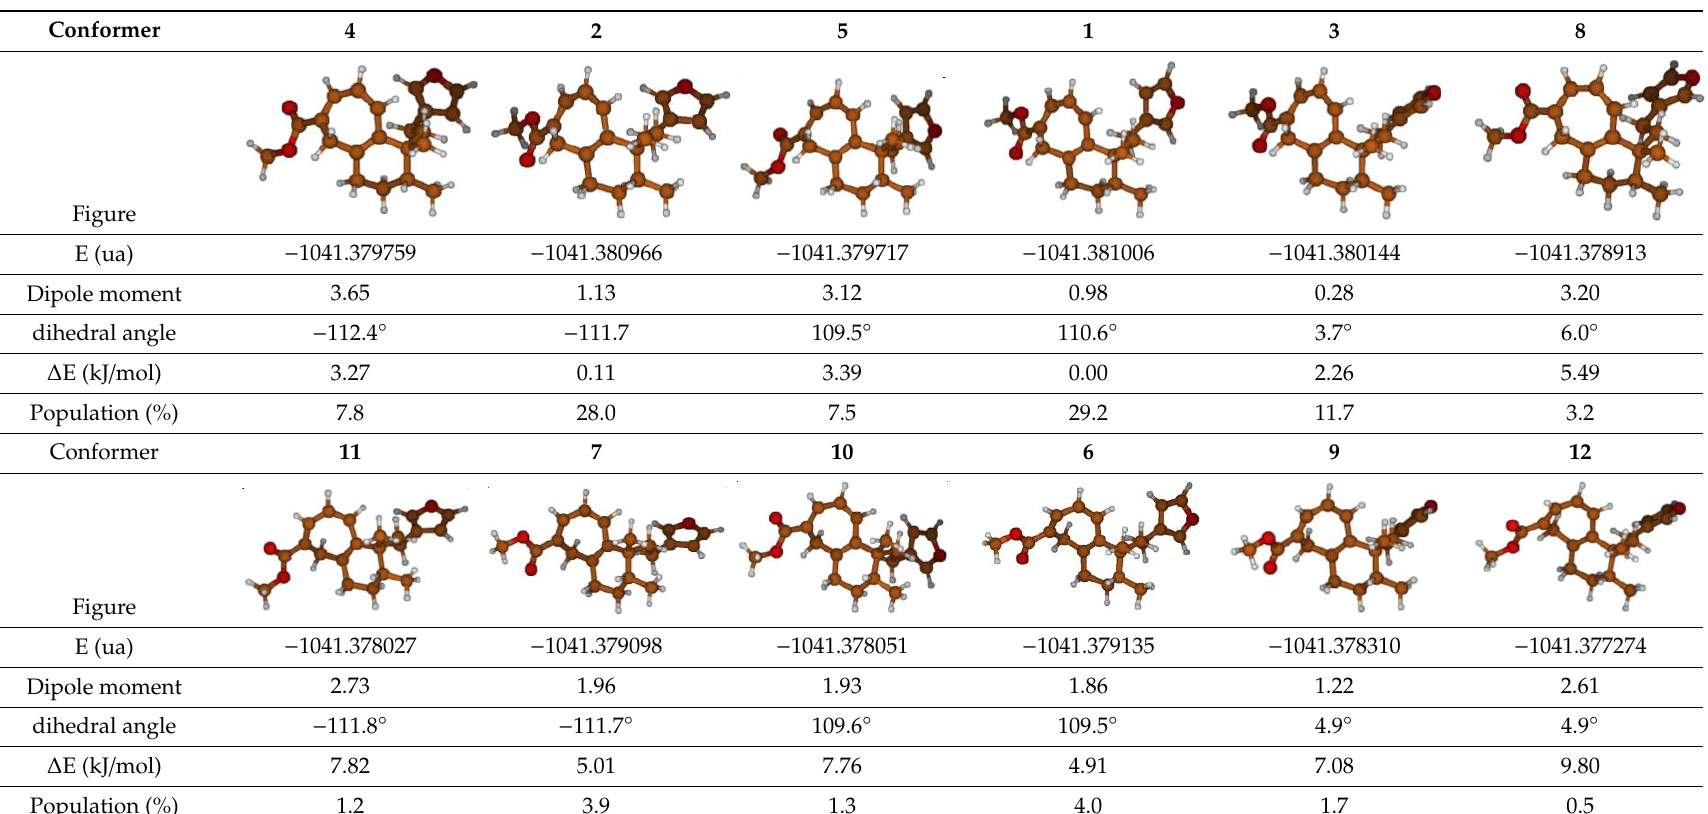
Table 6. Calculated B3LYP / 6-311 + G(d,p) Energies a , Dipole moments (Debye), relatives Energies a , (C 13 -C 14 -C 15 -C 18 ) dihedral angle, equilibrium population at 25 ◦ C Table 6. Calculated B3LYP/6-311+G(d,p) Energies a , Dipole moments (Debye), relatives Energies a , (C 13 -C 14 -C 15 -C 18 ) dihedral angle, equilibrium population at 25°C Table 6. Calculated B3LYP/6-311+G(d,p) Energies a , Dipole moments (Debye), relatives Energies a , (C 13 -C 14 -C 15 -C 18 ) dihedral angle, equilibrium population at 25°C Table 6. Calculated B3LYP/6-311+G(d,p) Energies a , Dipole moments (Debye), relatives Energies a , (C 13 -C 14 -C 15 -C 18 ) dihedral angle, equilibrium population at 25°C Table 6. Calculated B3LYP/6-311+G(d,p) Energies a , Dipole moments (Debye), relatives Energies a , (C 13 -C 14 -C 15 -C 18 ) dihedral angle, equilibrium population at 25°C Table 6. Calculated B3LYP/6-311+G(d,p) Energies a , Dipole moments (Debye), relatives Energies a , (C 13 -C 14 -C 15 -C 18 ) dihedral angle, equilibrium population at 25°C Table 6. Calculated B3LYP/6-311+G(d,p) Energies a , Dipole moments (Debye), relatives Energies a , (C 13 -C 14 -C 15 -C 18 ) dihedral angle, equilibrium population at 25°C Table 6. Calculated B3LYP/6-311+G(d,p) Energies a , Dipole moments (Debye), relatives Energies a , (C 13 -C 14 -C 15 -C 18 ) dihedral angle, equilibrium population at 25°C Table 6. Calculated B3LYP/6-311+G(d,p) Energies a , Dipole moments (Debye), relatives Energies a , (C 13 -C 14 -C 15 -C 18 ) dihedral angle, equilibrium population at 25°C Table 6. Calculated B3LYP/6-311+G(d,p) Energies a , Dipole moments (Debye), relatives Energies a , (C 13 -C 14 -C 15 -C 18 ) dihedral angle, equilibrium population at 25°C Table 6. Calculated B3LYP/6-311+G(d,p) Energies a , Dipole moments (Debye), relatives Energies a , (C 13 -C 14 -C 15 -C 18 ) dihedral angle, equilibrium population at 25°C Table 6. Calculated B3LYP/6-311+G(d,p) Energies a , Dipole moments (Debye), relatives Energies a , (C 13 -C 14 -C 15 -C 18 ) dihedral angle, equilibrium population at 25°C and figures of conformations 1-12 of the 8 R , 9 R isomer of methyl dodovisate A ( 2 ). Table 6. Calculated B3LYP/6-311+G(d,p) Energies a , Dipole moments (Debye), relatives Energies a , (C 13 -C 14 -C 15 -C 18 ) dihedral angle, equilibrium population at 25°C and figures of conformations 1-12 of the 8 R , 9 R isomer of methyl dodovisate A ( 2 ). and figures of conformations 1-12 of the 8 R , 9 R isomer of methyl dodovisate A ( 2 ). and figures of conformations 1-12 of the 8 R , 9 R isomer of methyl dodovisate A ( 2 ). and figures of conformations 1-12 of the 8 R , 9 R isomer of methyl dodovisate A ( 2 ). and figures of conformations 1-12 of the 8 R , 9 R isomer of methyl dodovisate A ( 2 ). and figures of conformations 1-12 of the 8 R , 9 R isomer of methyl dodovisate A ( 2 ). and figures of conformations 1-12 of the 8 R , 9 R isomer of methyl dodovisate A ( 2 ). and figures of conformations 1-12 of the 8 R , 9 R isomer of methyl dodovisate A ( 2 and figures of conformations 1-12 of the 8 R , 9 R isomer of methyl dodovisate A ( 2 ). and figures of conformations 1-12 of the 8 R , 9 R isomer of methyl dodovisate A ( 2 ). and figures of conformations 1-12 of the 8 R , 9 R isomer of methyl dodovisate A ( 2 ). and figures of conformations 1-12 of the 8 R , 9 R isomer of methyl dodovisate A ( 2 ). Conformer Conformer